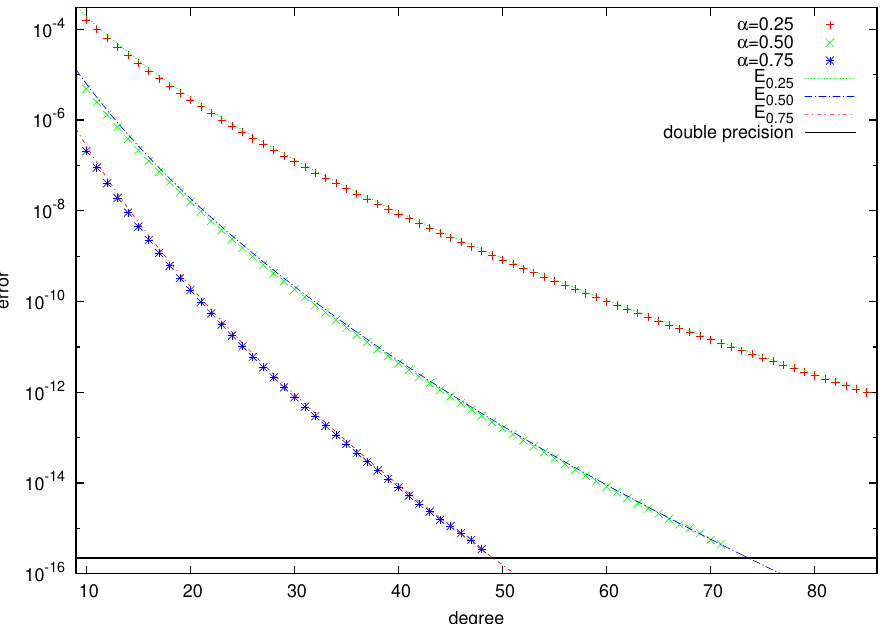
Figure 1. The errors of the rational approximation of t α for the values of α = 1 estimate of the errors of the